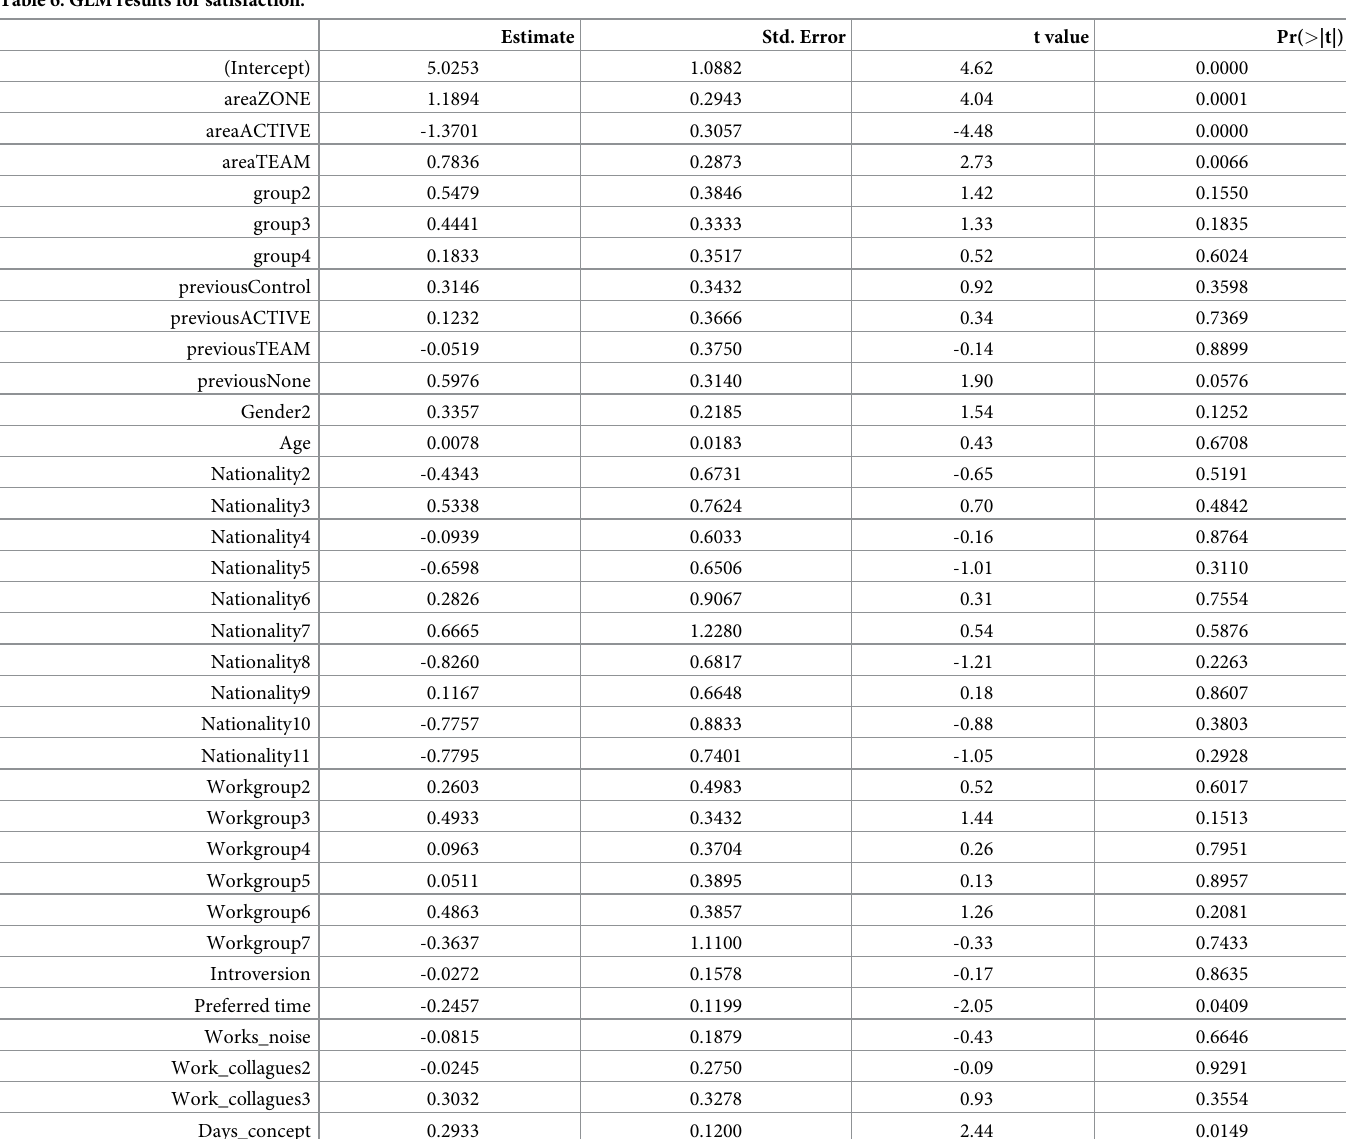
Table 6. GLM results for